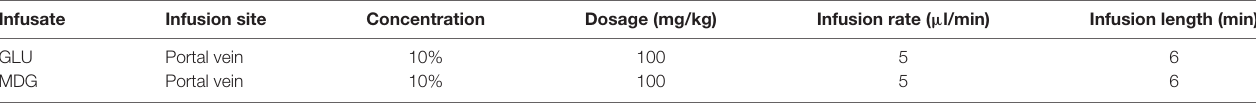
TABLE 1 | Parameter for sugar infusion during microdialysis sampling. Infusate Infusion site Concentration Dosage (mg/kg) Infusion rate ( µ l/min) Infusion length (min) GLU Portal vein 10% 100 5 6 MDG Portal vein 10% 100 Both GLU and MDG solution used in portal vein infusion were prepared with heparinized saline solution (heparin: 100U/ml). To verify patency of intra-portal catheters, the tubing was filled with 100U/mL heparin and flushed daily until the experiments were